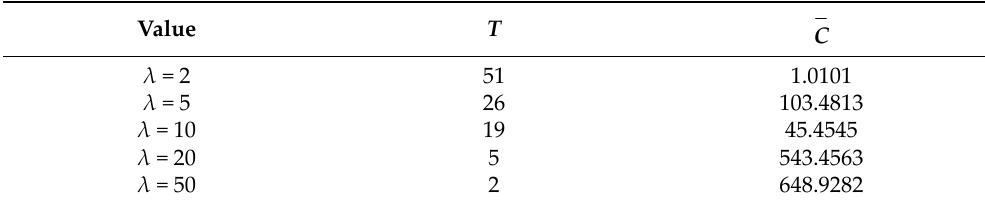
Table 2. Optimal results for several alterative values for λ